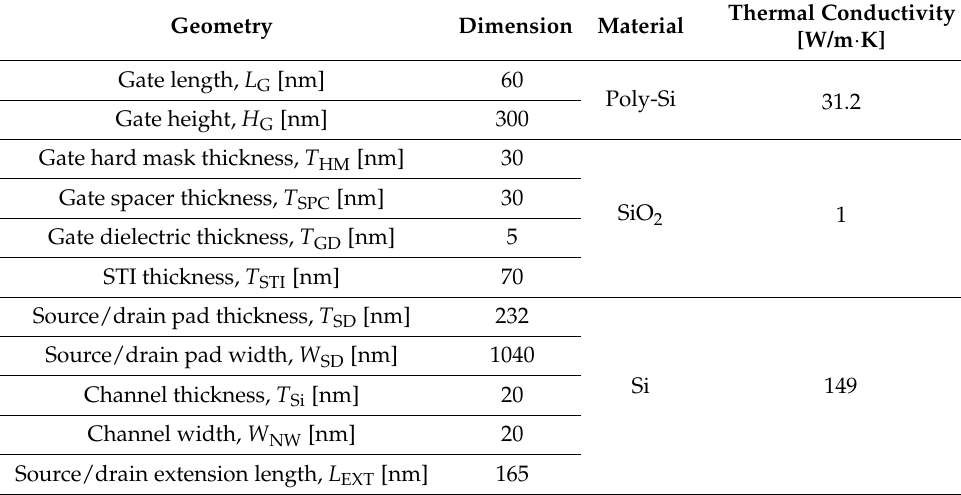
Table 1. Dimensional and material parameters for COMSOL simulations.